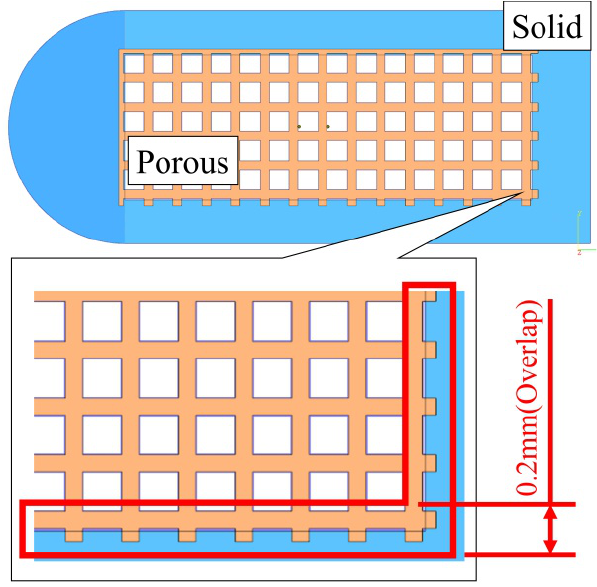
Figure 1. Schematic diagram of commercial porous fusion cage structure was fabricated by selective electron beam additive manufacture (SEBAM) method using gradient energy density on three different zones. Solid and porous parts were made independently by higher and lower energy density. The overlap site with 0.2 mm in width between solid and porous parts was made sequentially by higher and lower energy density.